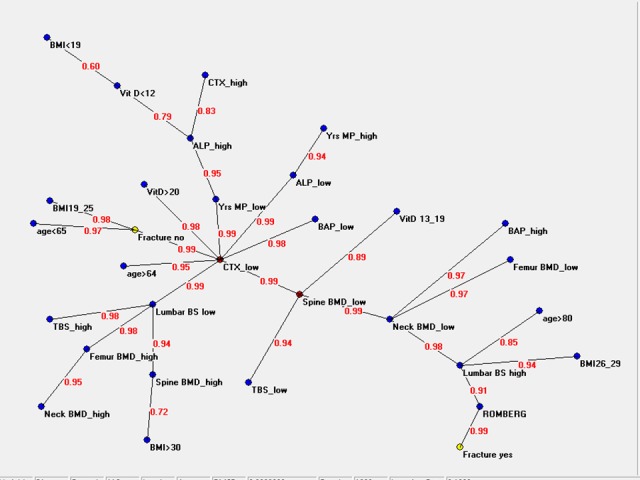
Semantic map showing the relations between the investigated anagraphic, antropometric, densitometric, biochemical and clinical parameters.